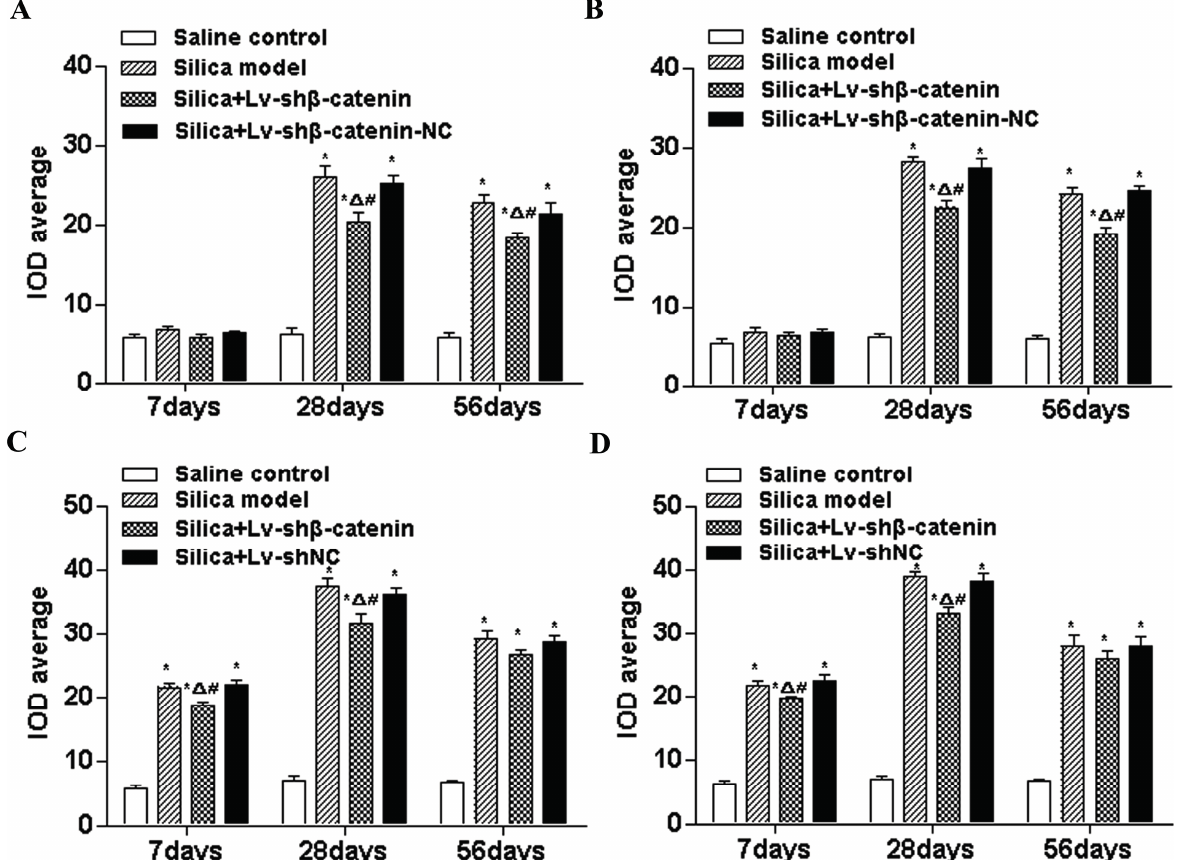
Figure 6. Average IOD of collagen I ( A ), collagen III ( B ), MMP2 ( C ) and MMP9 ( D ) in the lung of mice at different time points after silica-administration. Data are expressed as mean ± SEM. (n = 6). * p < 0.05, compared to the saline control group; Δ p < 0.05, compared to the silica group; # p < 0.05, compared to the silica + Lv-sh β -catenin-NC